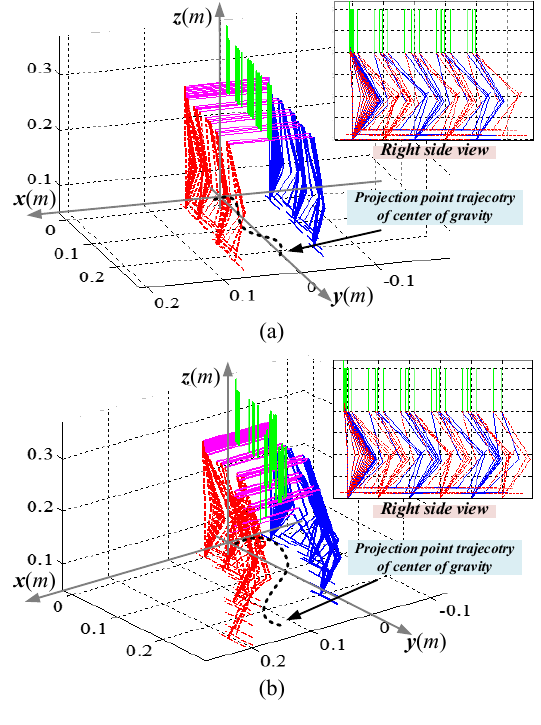
Fig. 11. Walking simulation results in Matlab. (a) Simulation result of straight walking. (b) Simulation of rotation.